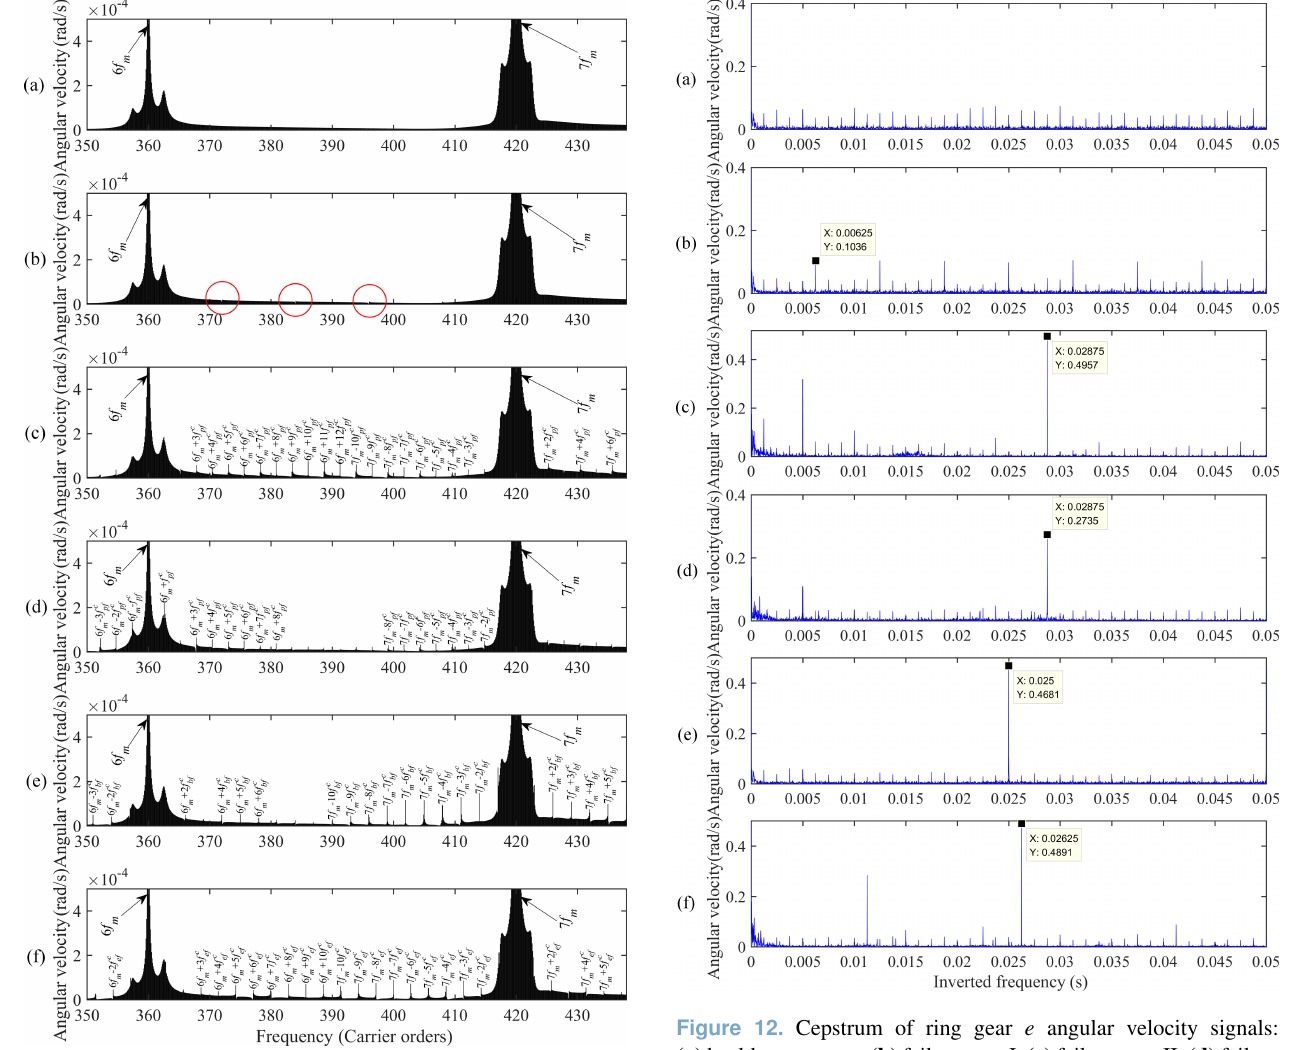
Figure 11. Frequency spectrum of ring gear e angular velocity sig- nals: (a) healthy gear case, (b) failure case I, (c) failure case II, (d) failure case III, (e) failure case IV, and (f) failure case V.